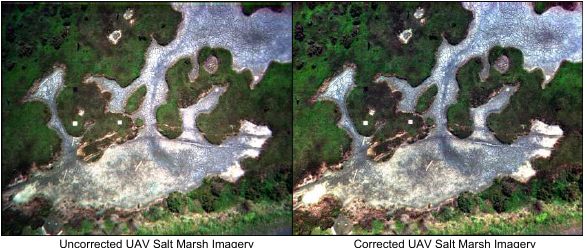
Figure 11: Visual comparison of the improvements by the appli- cation of sensor corrections and radiometric calibration (Image Bands